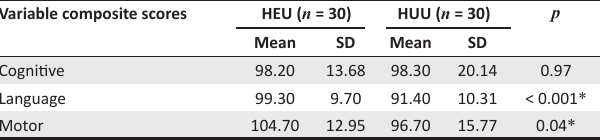
TABLE 3: Developmental scores for human immunodeficiency virus-exposed uninfected and human immunodeficiency virus-unexposed uninfected premature infants.